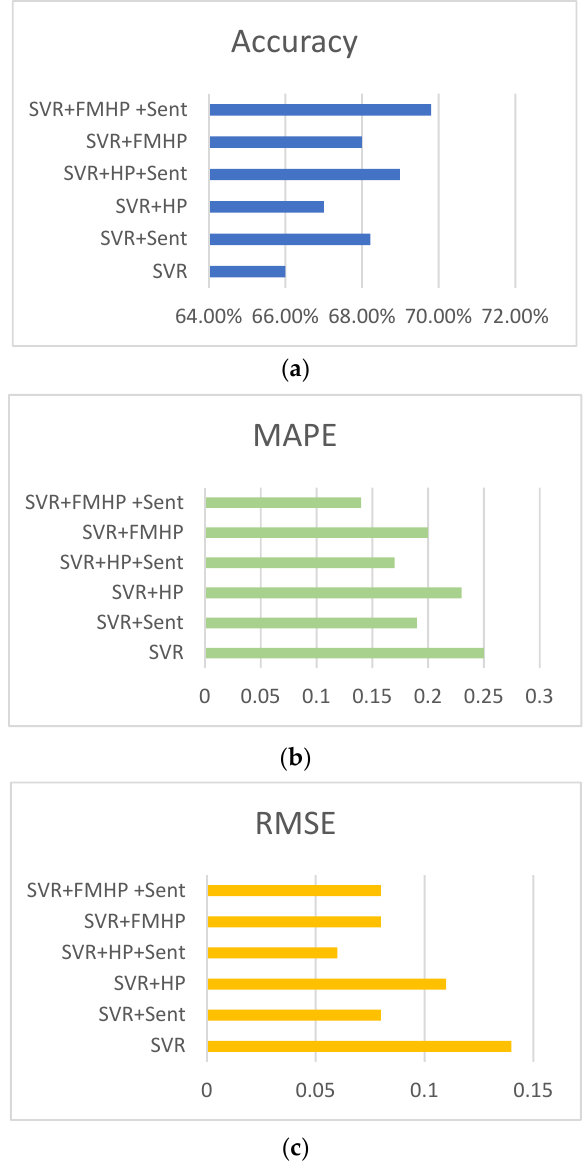
Figure 6. Performance of SVR in predicting the closing price of AAPL ( a ) prediction accuracy, ( b ) MAPE, and ( c ) RMSE.